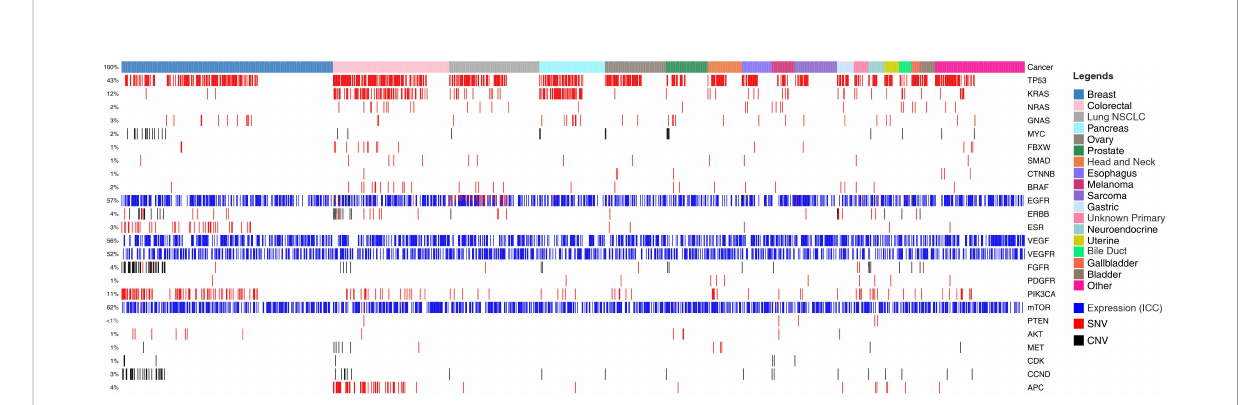
FIGURE 1 Landscape of Genomic Alterations in the Feasibility Study Cohort. Colour coded boxes in the topmost row indicate cancer types. Each vertical column indicates a single patient. Features such as Single Nucleotide Variations (SNVs) are represented by red colour; Copy Number Variations (CNVs; gain) by black; and ICC based gene expression analysis by blue. Gene names are enlisted on right Y-axis and the % of specimens harbouring the different features are enlisted on left